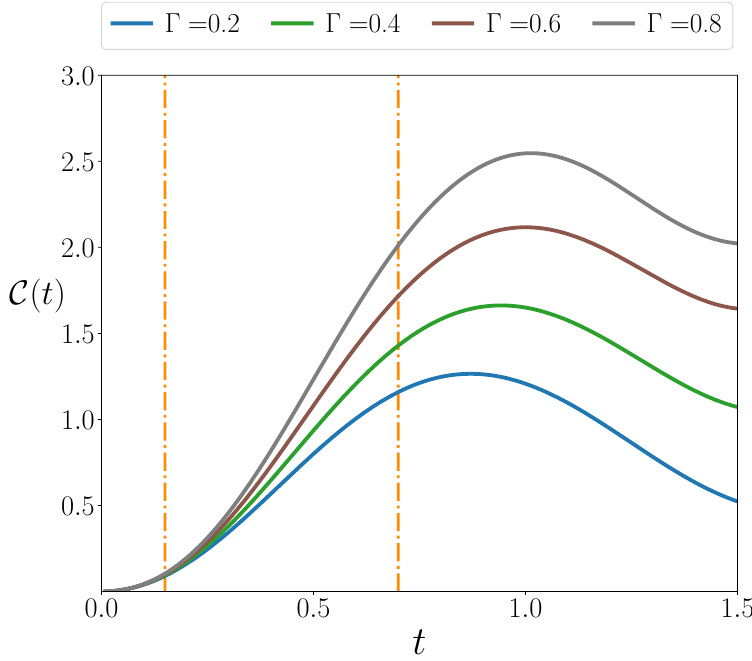
Figure 6: The time development of the commutator squared value is shown for dif- ferent rates ( Γ ) of the smooth quench. The dashed-dotted lines represent the points in the plot with increasing ramps which we use to extract the Lyapunov